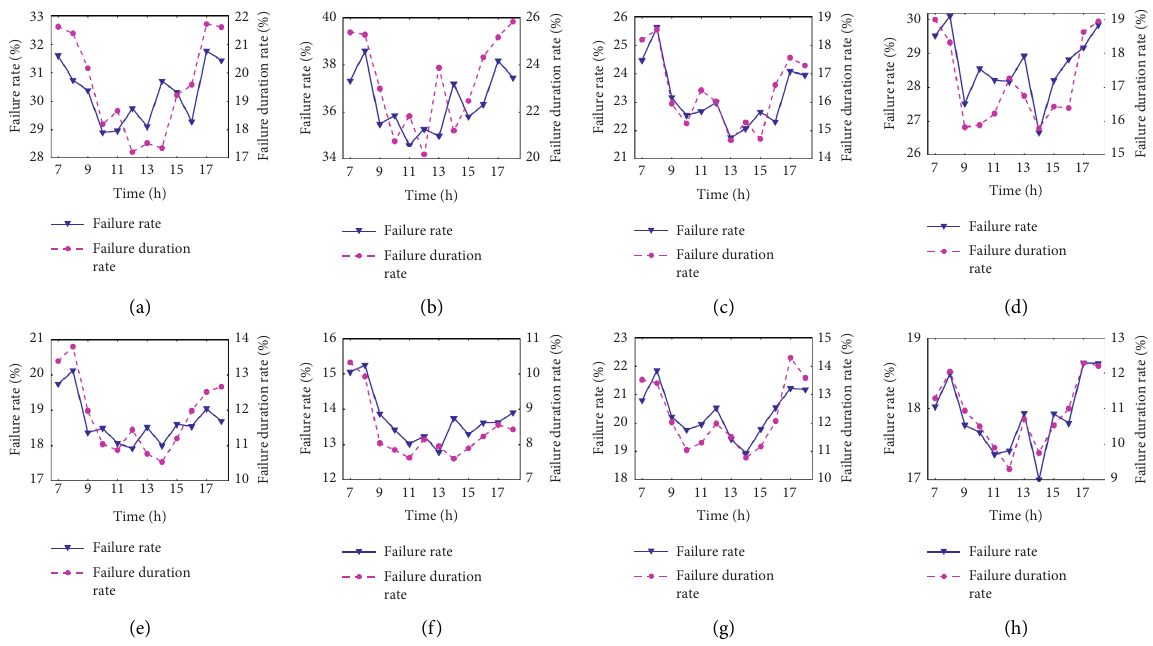
Figure 3: Bus stop failure time-varying characteristics of test bus stops. (a) No.1 bus stop. (b) No.2 bus stop. (c) No.3 bus stop. (d) No.4 bus stop. (e) No.5 bus stop. (f) No.6 bus stop. (g) No.7 bus stop. (h) No.8 bus